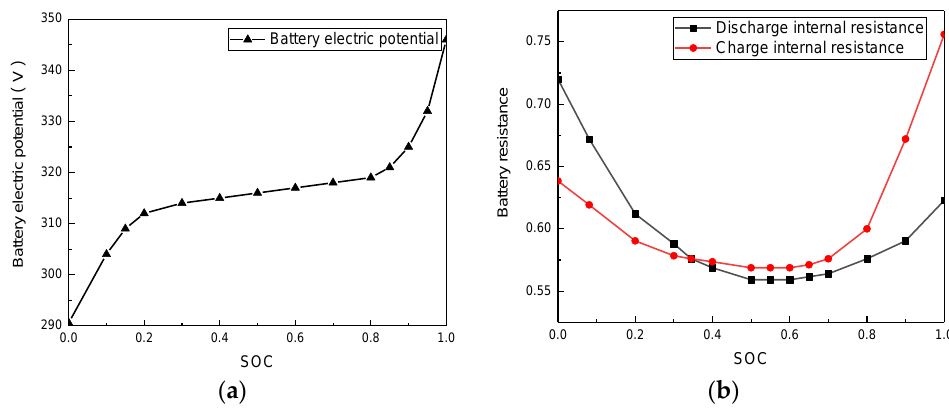
Figure 4. Battery model, ( a ) Battery internal resistance model; ( b ) Battery electric potential model.